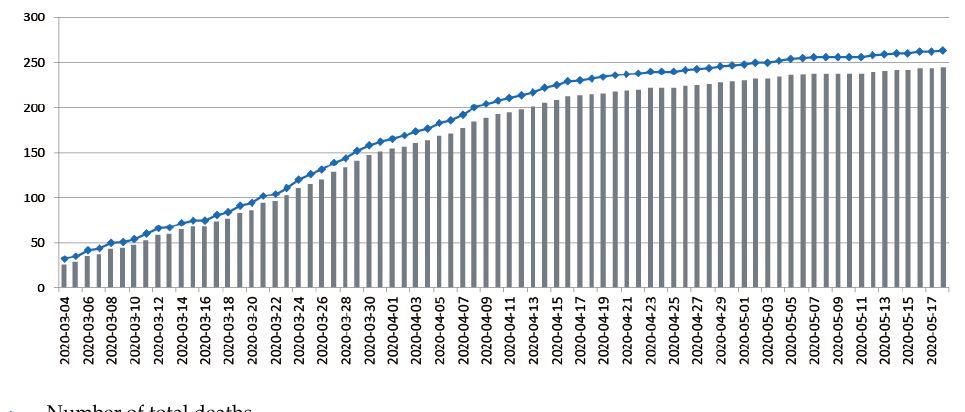
Figure 2. Cumulative number of deaths by SARS-CoV-2 in South Korea.